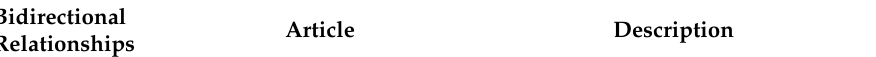
Table 1. Links between PD, sleep and glymphatic